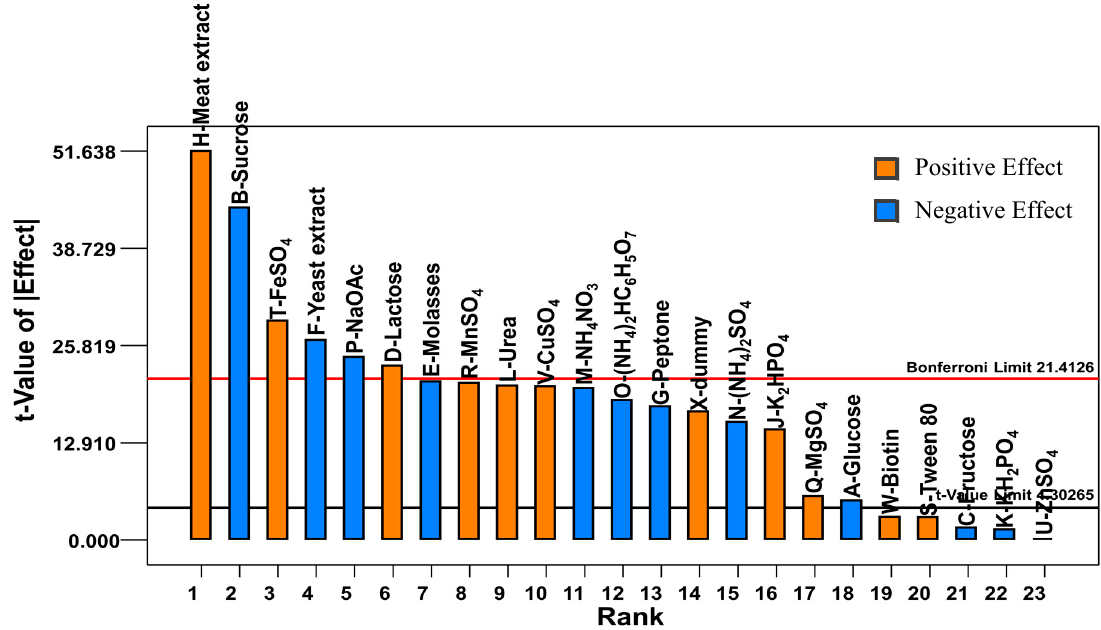
Figure 1. Effects of different medium components on tryptophan production by P. acidilactici TP-6. Figure 1. E ff ects of di ff erent medium components on tryptophan production by P. acidilactici